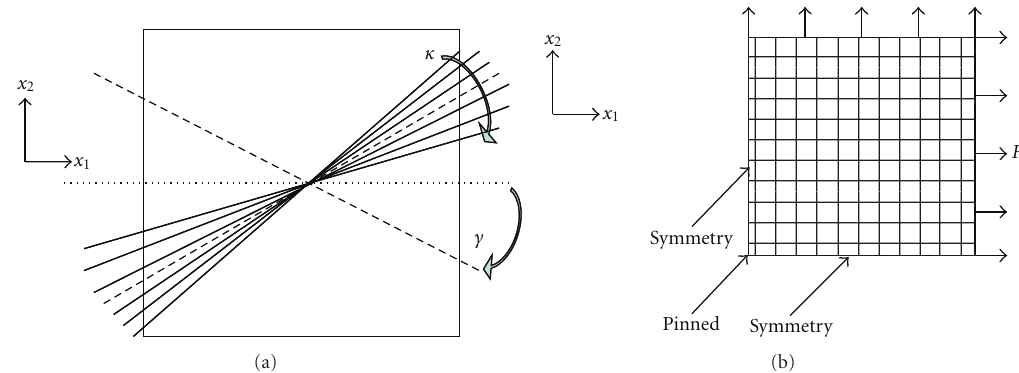
Figure 2: (a) Definition of fiber orientation γ and fiber dispersion κ in a tissue sample. (b) Finite element model with loading and boundary